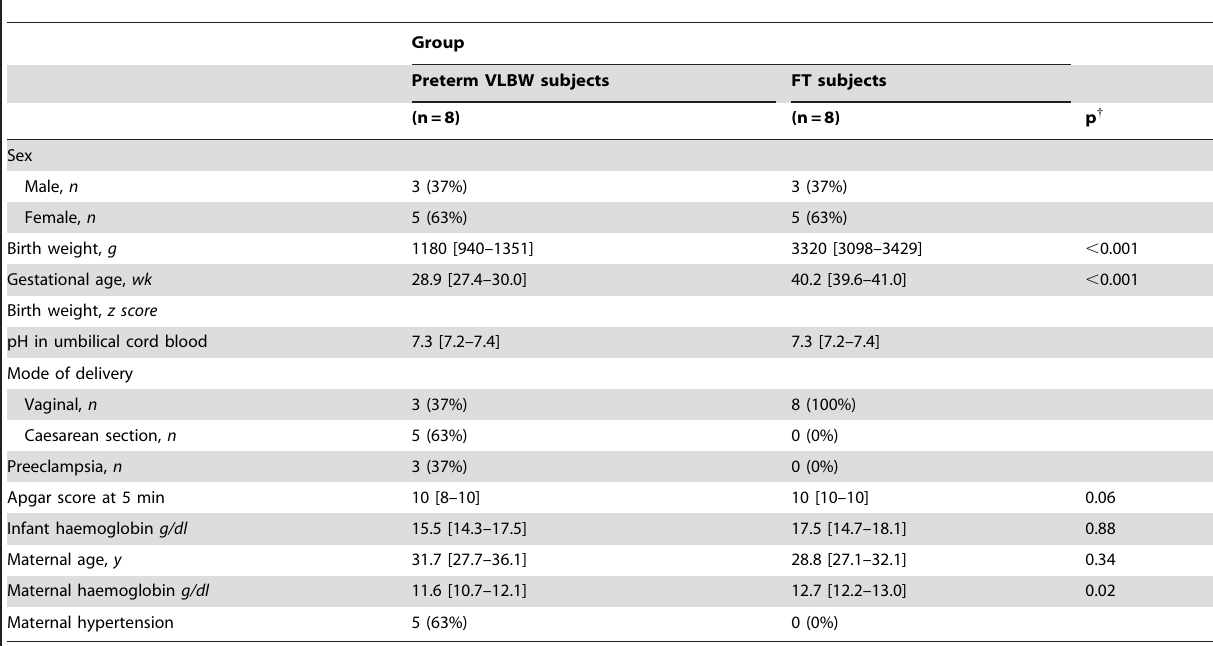
Table 1. Selected clinical characteristics of enrolled infants and their mothers.